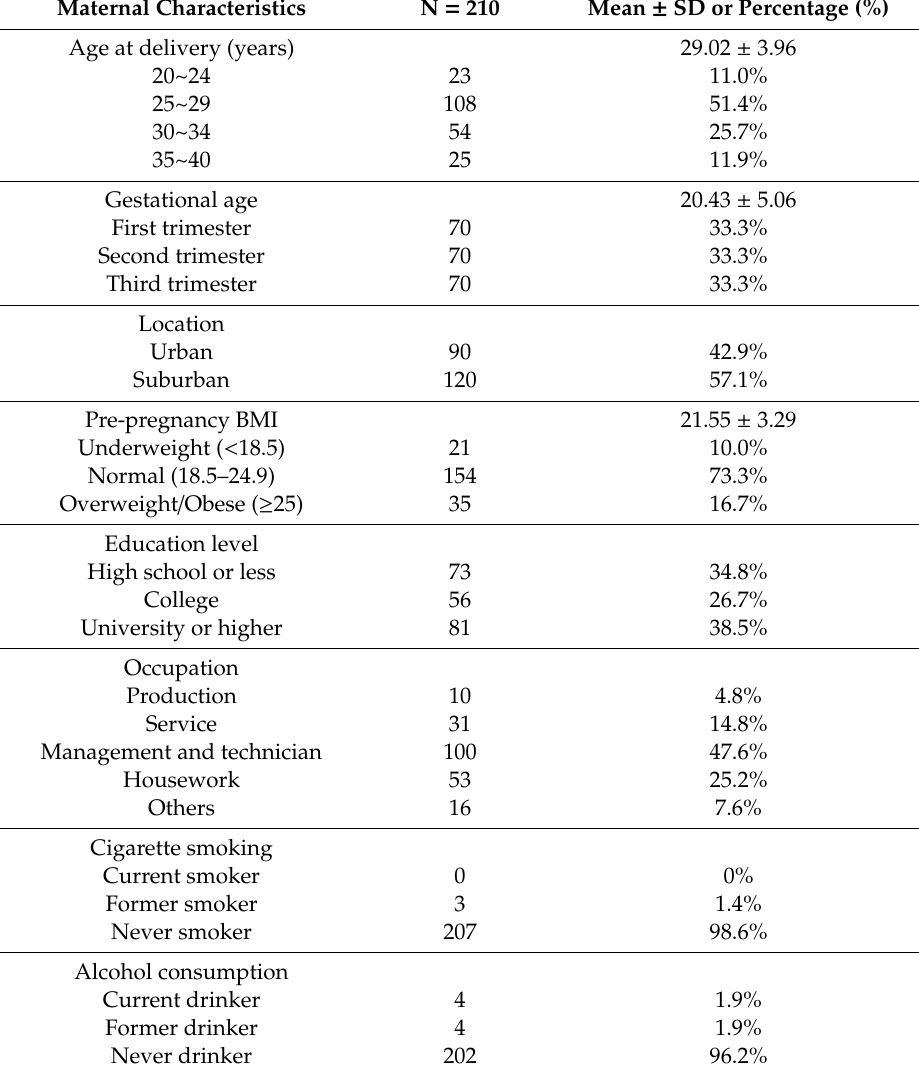
Table 1. Characteristics of the participating pregnant